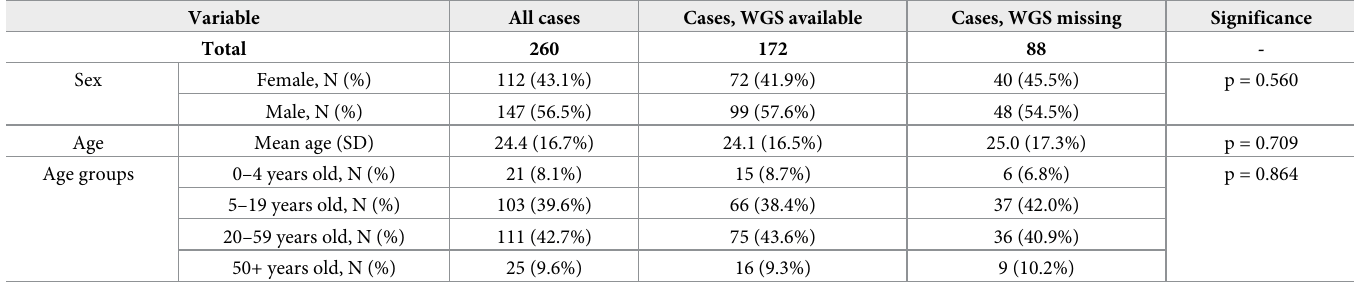
Table 1. Comparison of age and sex variables of acute cases associated with an S . Typhi whole genome sequence (WGS) versus acute cases missing WGS data. Variable